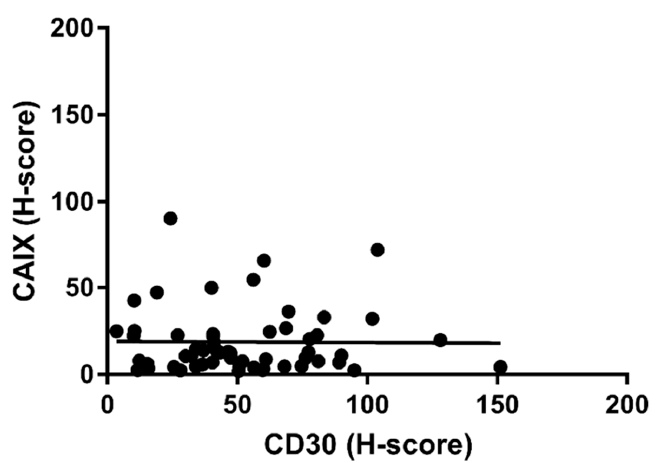
Figure 4. The CD30 related H-score representing the HRS cell burden did not correlate with the amount of CAIX expression in individual CAIX + cHL samples ( p -value = 0.4755, Spearman rs: − 0.008).